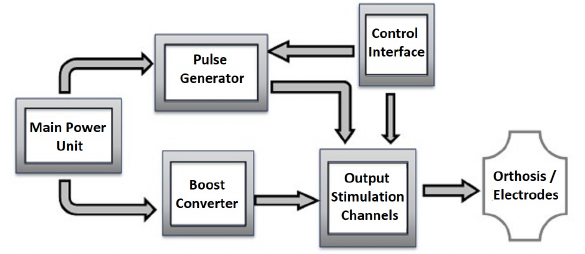
Figure 1. Generic block diagram of a